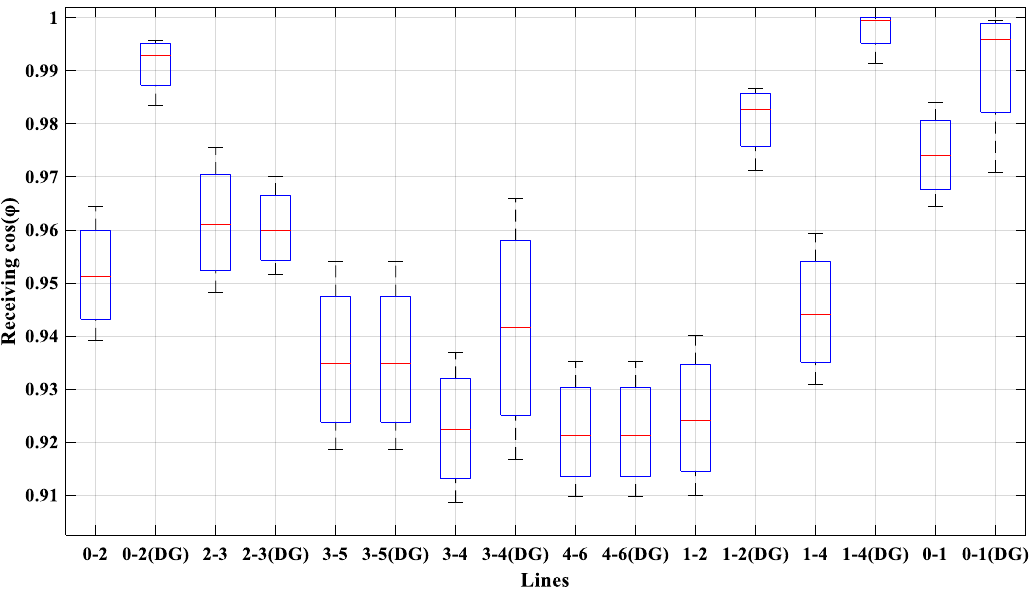
Figure 11. Receiving cos(φ) for all transmission lines.